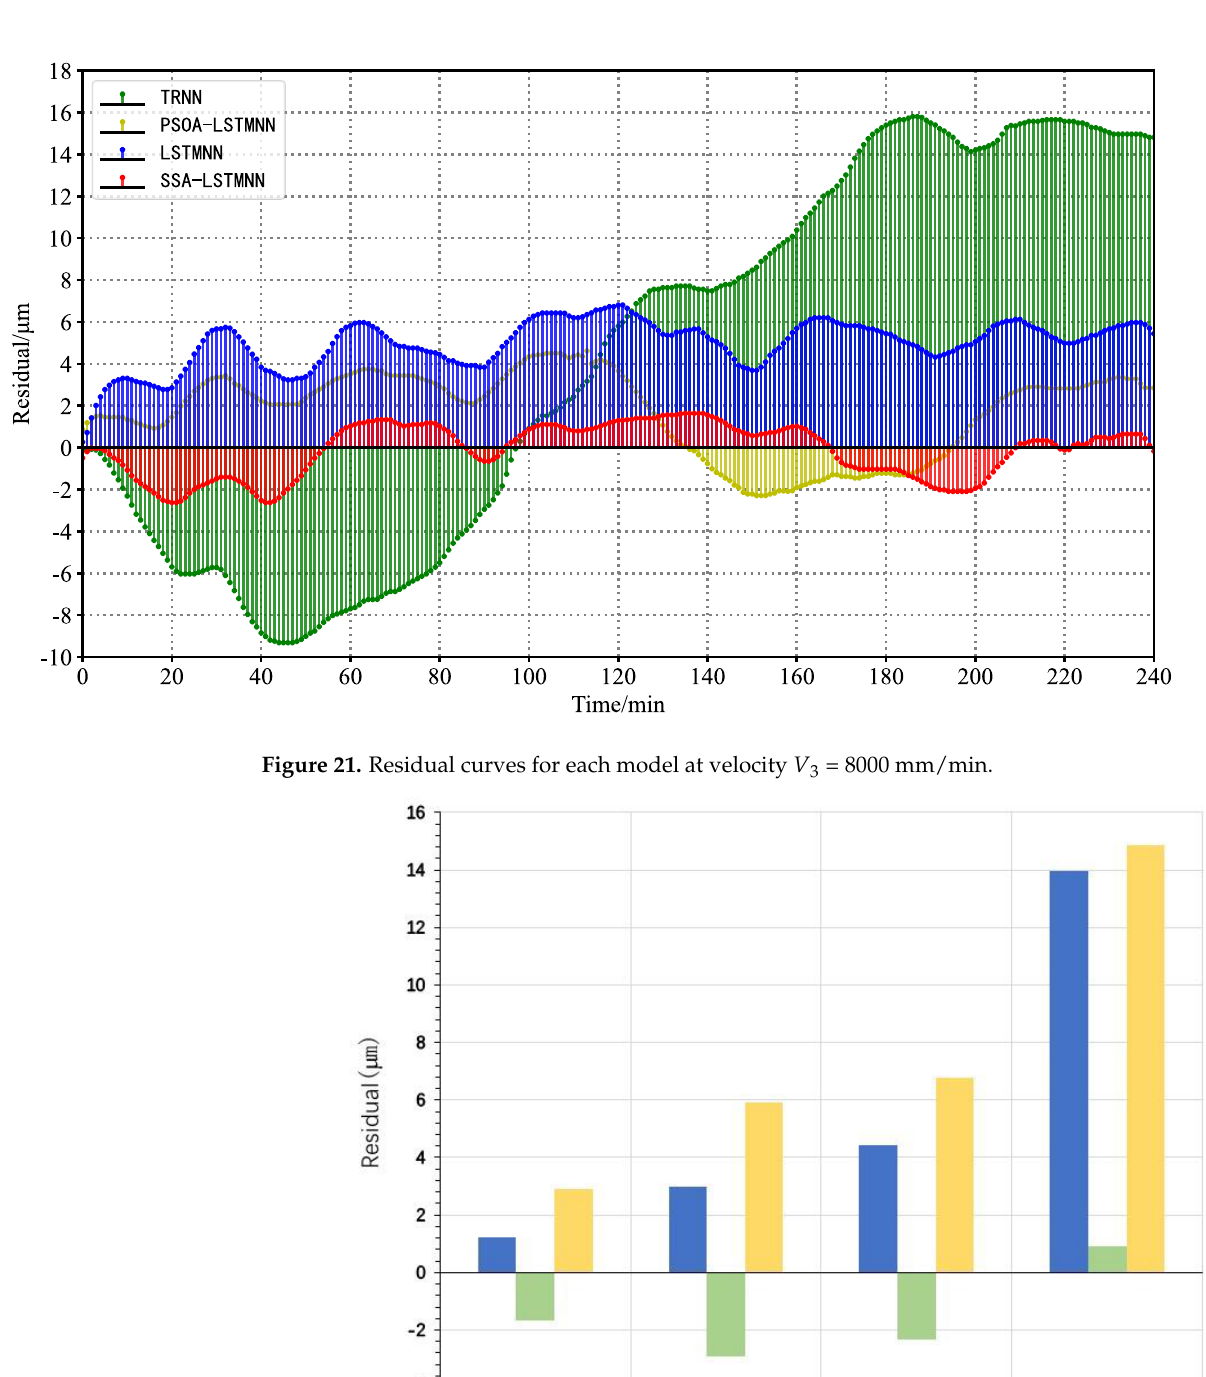
Figure 22. Residual details of each model at speed V 2 = 5000 mm/min.